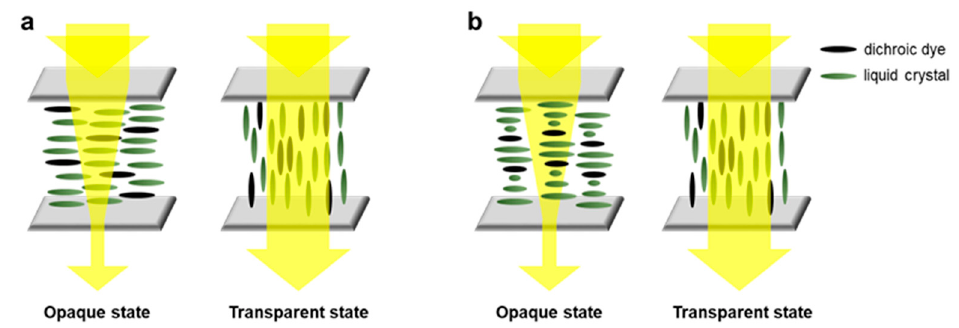
Figure 3. The schematic representation of ( a ) ECB and ( b ) ChLC cells.